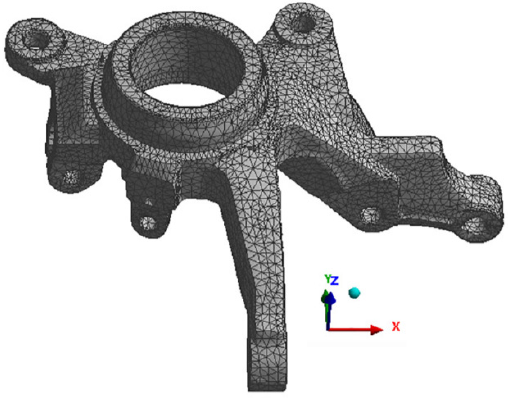
Figure 8. The FEM of the automotive steering knuckle based on sensitivity analysis of response to the number of meshes [53].